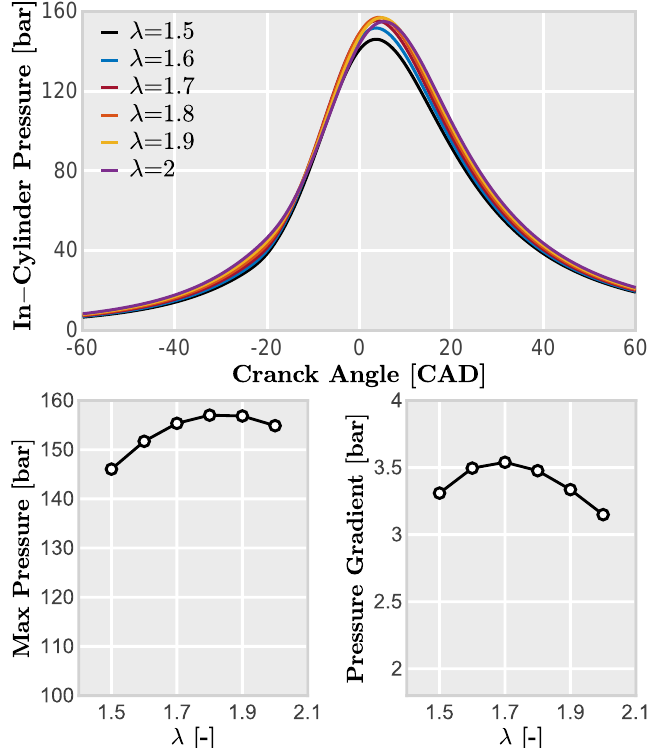
Figure 16. In-cylinder pressure evolution. Pressure profiles ( top ), maximum peak pressure ( bottom- left ), and maximum pressure change rate ( bottom-right ) for different air-to-fuel ratios considering hydrogen fuel.